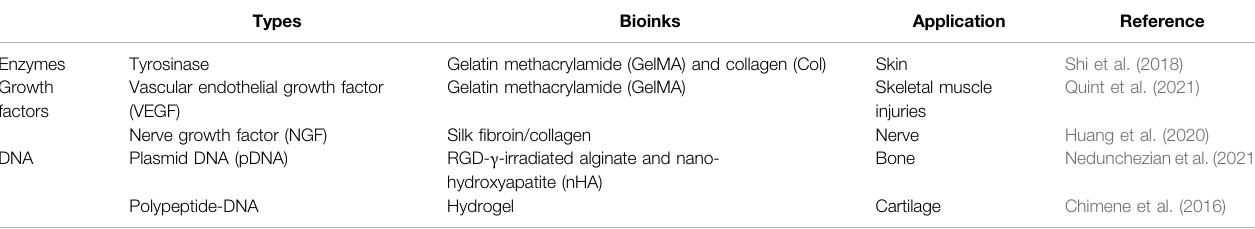
TABLE 2 | Different bioactive molecule types for 3D